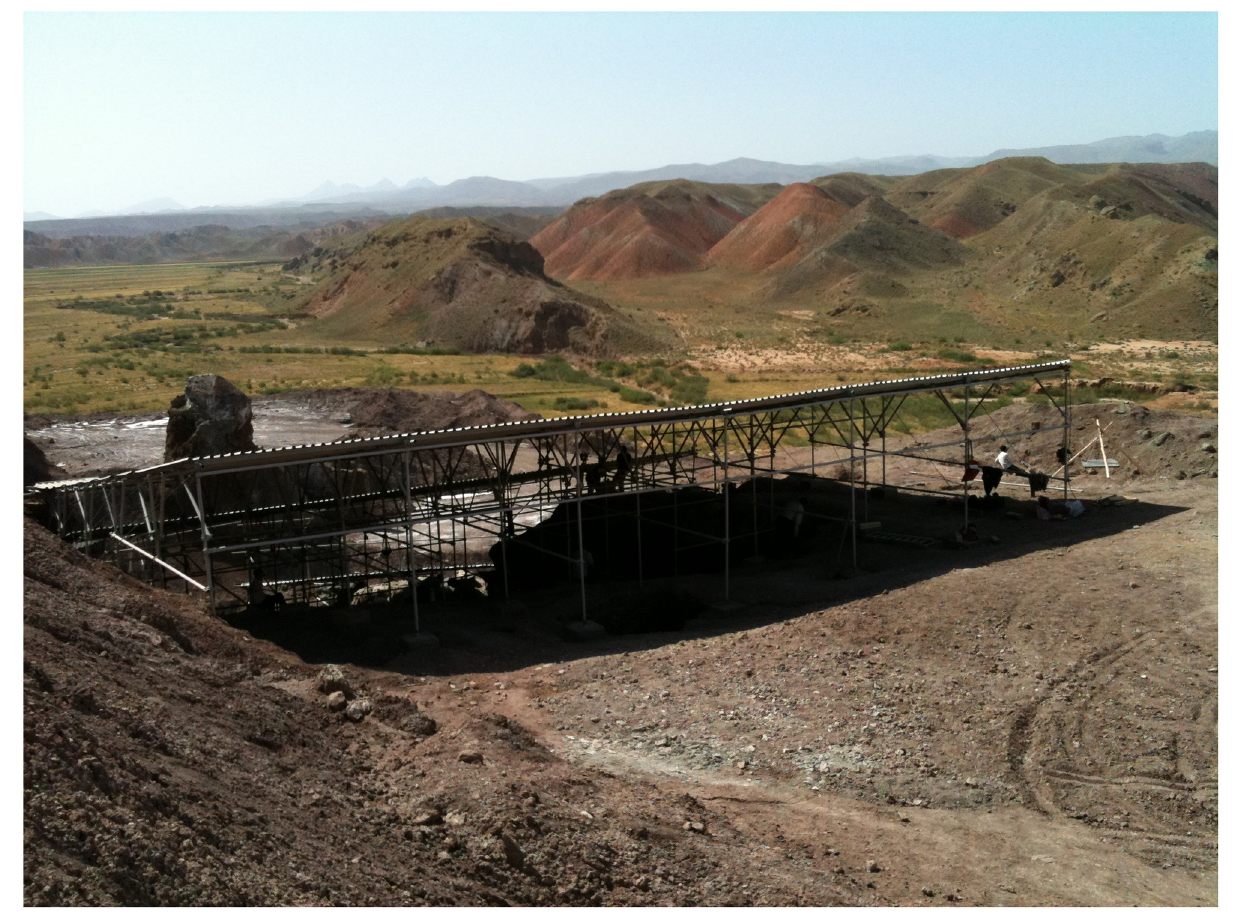
Fig 1. Chehr ā b ā dsalt mine; excavation site. Photo taken by Frank